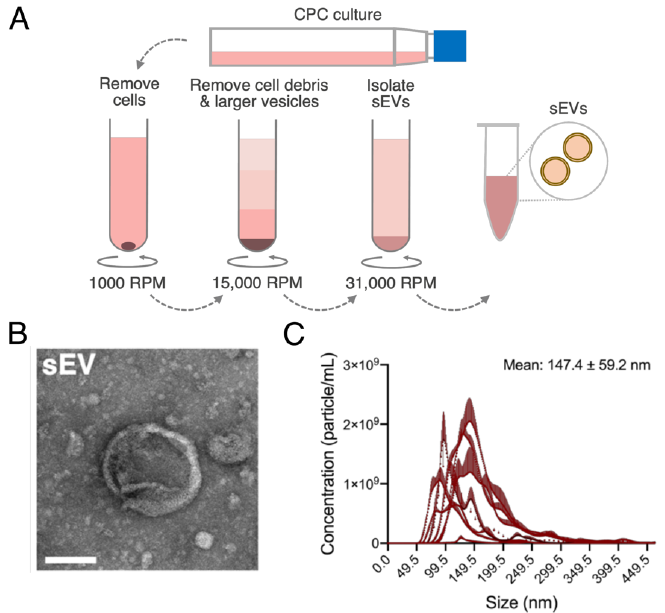
Figure 1. Cardiac ckit+ progenitor cell (CPC)-derived small extracellular vesicle (sEV) isolation and characterization. ( A ) Workflow of sEV isolation from 2D cultures of CPCs with differential ultracentrifugation to sequentially remove cells, cell debris and larger vesicles. ( B ) Transmission electron microscopy image of isolated CPC-sEV. Scale bar = 100 nm. ( C ) Concentration-size profile of isolated sEVs with nanoparticle tracking analysis (NTA). n = 11.